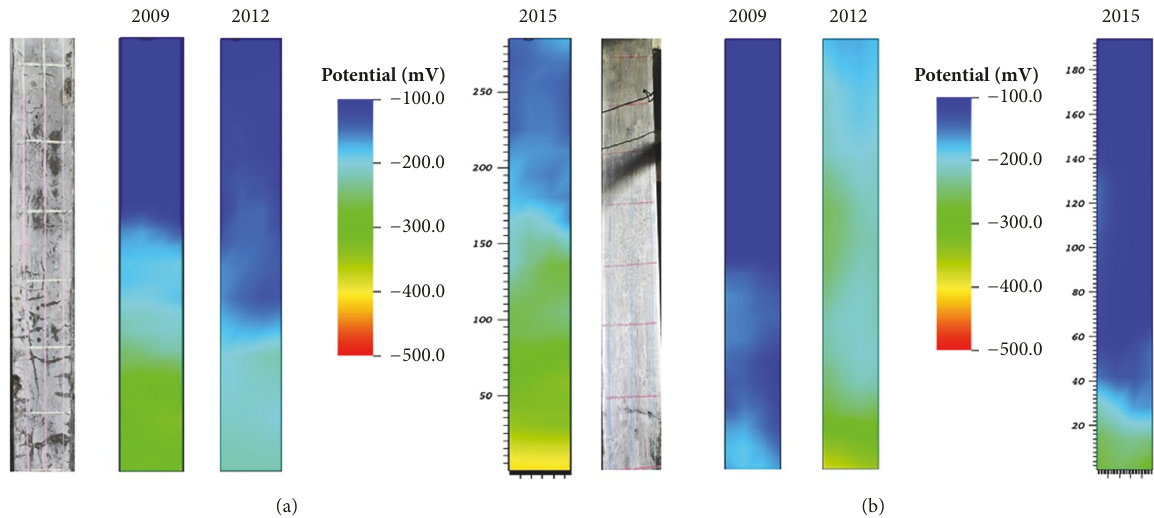
Figure 11: The potential distribution on the column for the previous study in Banda Aceh city, Indonesia: (a) indicating an increase of corrosion risk and (b) indicating repassivation [6].